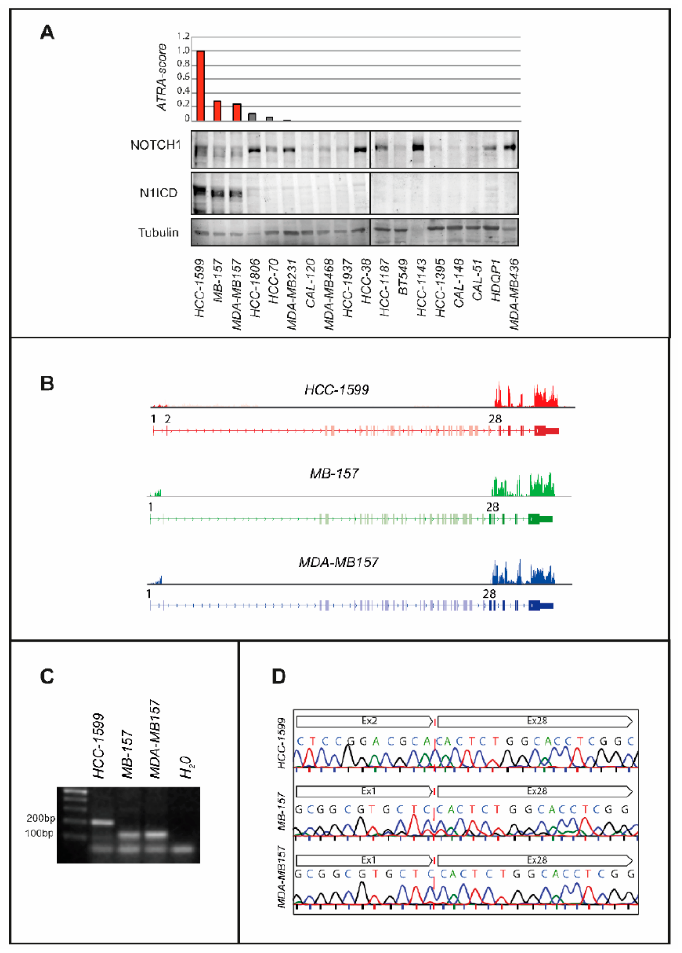
Figure 1. ATRA sensitivity and N1ICD expression in TNBC cell lines. ( A ) Upper: TNBC cell lines are ranked in descending order according to the ATRA-score shown by the bar graph. The cell lines characterized by internal deletions of the NOTCH1 gene are marked in red. Each ATRA-score value is representative of at least two independent experiments. The cell lines are ordered according to decreasing ATRA-sensitivity from left to right. Lower: The Western blots shown illustrate the levels of NOTCH1, the N1ICD cleavage and transcriptionally active product (Val1744) of NOTCH1 and tubulin (internal control), which were determined using specific antibodies. The densitometric analyses of the Western blots presented are available in Figure S5. ( B ) The panel shows density-plots